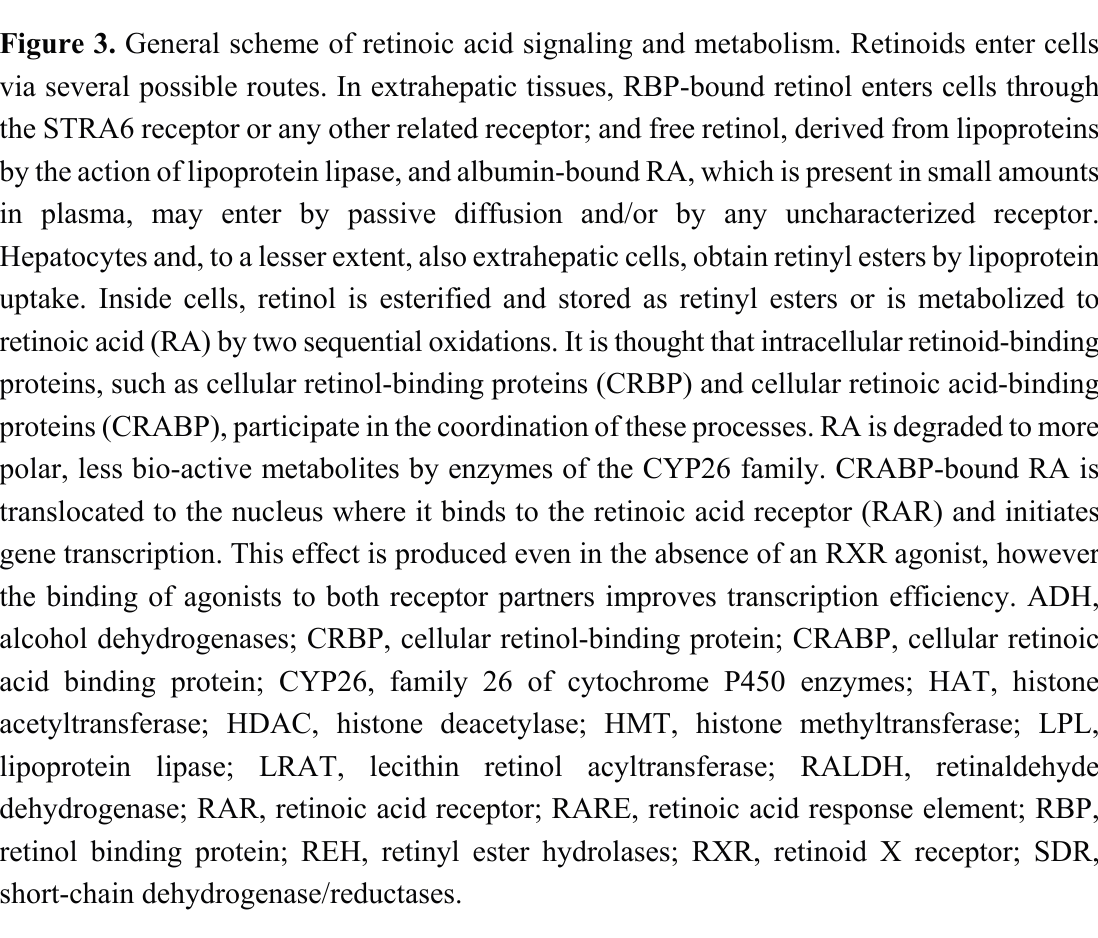
Figure 3. General scheme of retinoic acid signaling and metabolism. Retinoids enter cells via several possible routes. In extrahepatic tissues, RBP-bound retinol enters cells